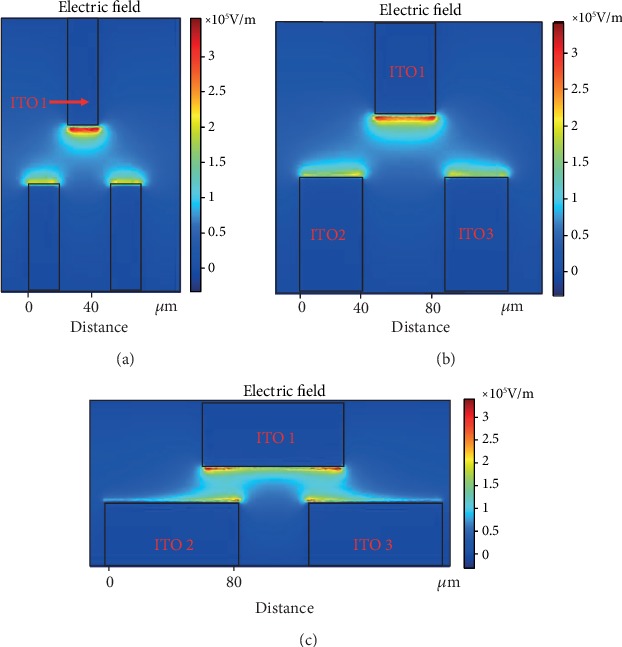
Diagram of the electric field between ITO electrodes. The width of the ITO electrode was set to (a) 20 μm, (b) 40 μm, and (c) 80 μm.